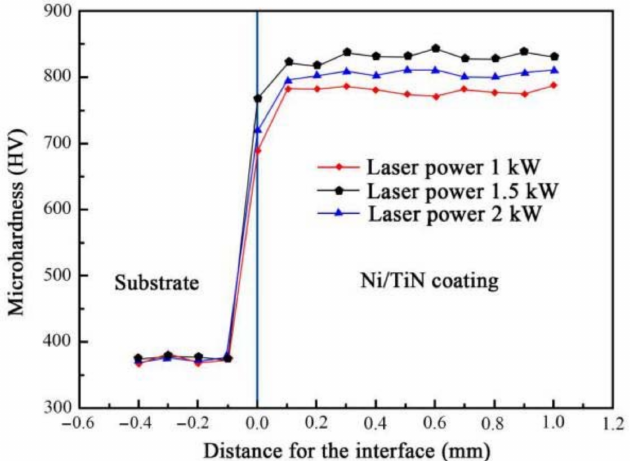
Figure 5. Microhardnesses of Ni/TiN coatings produced at various laser